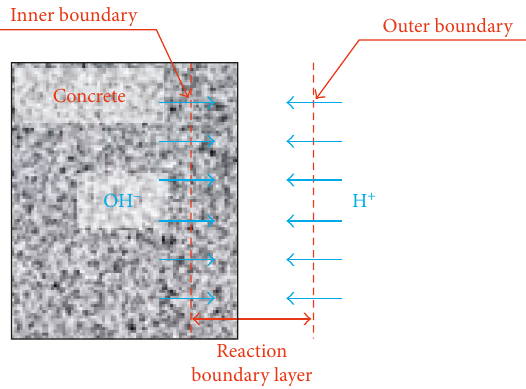
Figure 1: Reaction boundary layer of sulfuric acid corrosion on